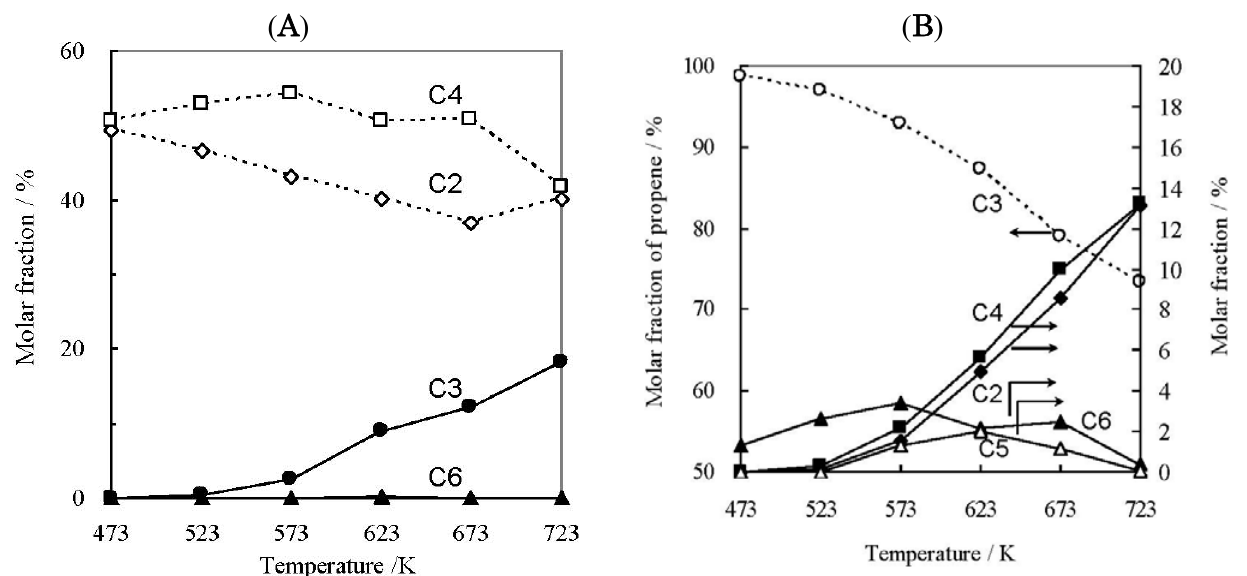
Figure 2. Metathesis reaction of ethene and 1-butene ( A , P ( B , P = 10%) on 0.3 g of Ni-M41(15). The codes C2–C6 mean ethene, propene, C3H6 butenes, pentenes, and hexenes. In Figure 2B, the left vertical axis is the amount of propene and the right those of the products.